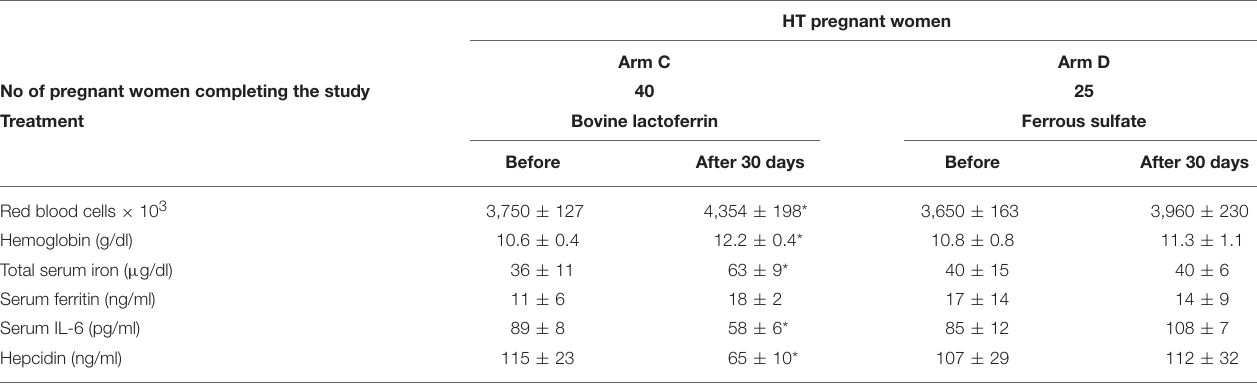
TABLE 6 | Hematological parameters, serum IL-6 and hepcidin mean values ± SD of HT pregnant women, suffering from AI, treated with bovine lactoferrin (Arm C) or with ferrous sulfate (Arm D), before and after 30 days of treatment.